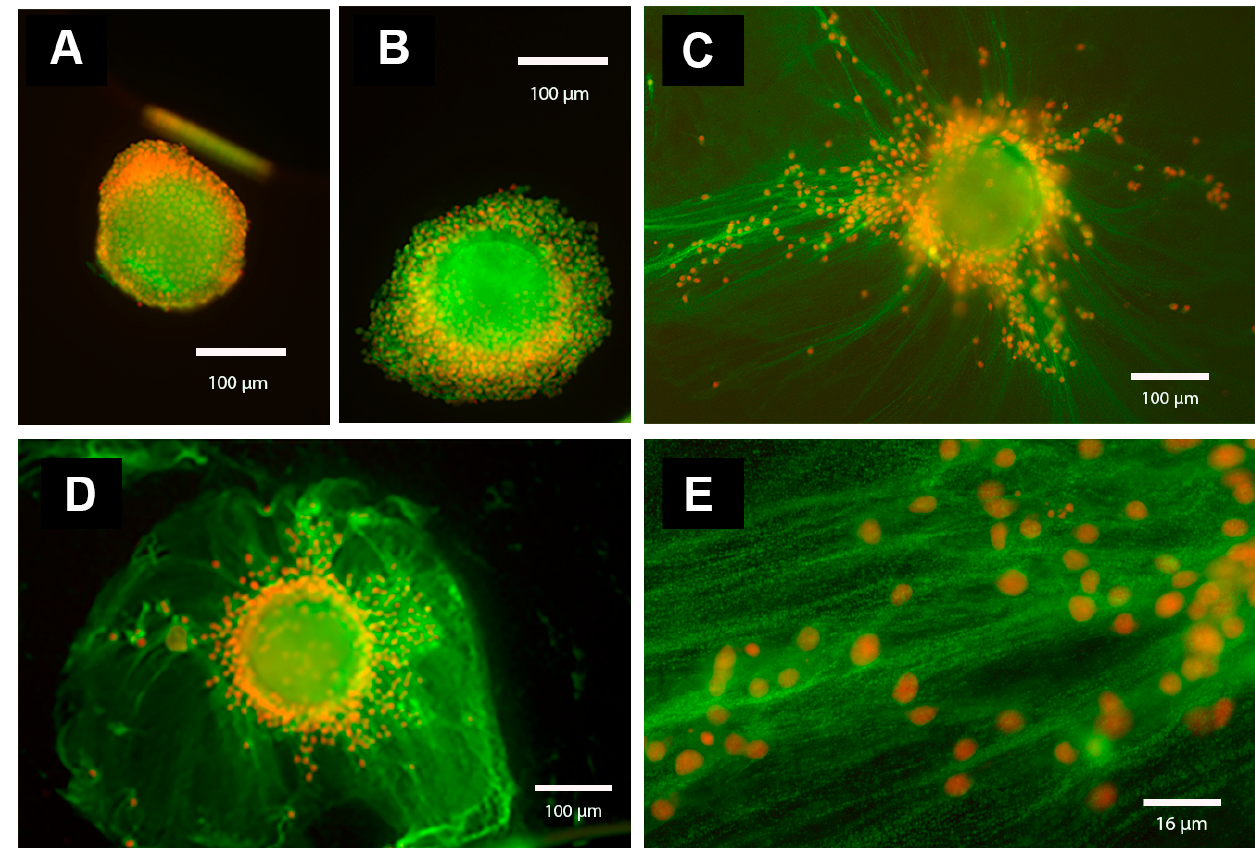
Figure 1. Immunofluorescence analysis of I α I components in the oocyte–cumulus ECM. Oocyte- cumulus complexes (OCCs) were cultured for 20 h without ( A ) or with ( B – E ) FSH (100 ng/mL) in the absence ( A , B ; in PVP-supplemented medium) or in the presence of serum (5 % FBS) ( C – E , magnification of ECM structure present in C ). In the absence of serum ( A , B ), the cumulus cells remain close to each other and to the oocyte, and the ECM is absent. In contrast, in the presence of serum and FSH ( C – E , magnification of the cumulus ECM structure present in C ), cumulus cells synthesize and organize an ECM structure that contains components immunoreactive for I α I and present as a network of cables. The immunofluorescence analysis was performed by using a rabbit anti-human I α I antibody (dilution 1:100; DAKO, Carpenteria, CA, USA) and Alexa Fluor 488 goat anti-rabbit IgG as a secondary antibody (dilution 1:500; Molecular Probes, green). Nuclei are in red.